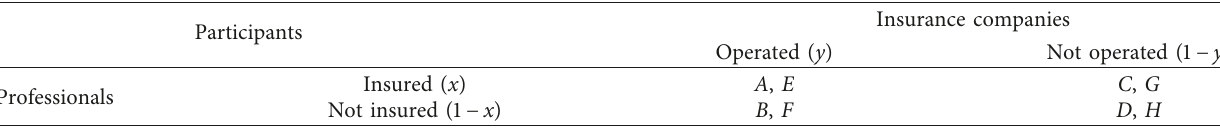
Table 2: Payoff matrix.